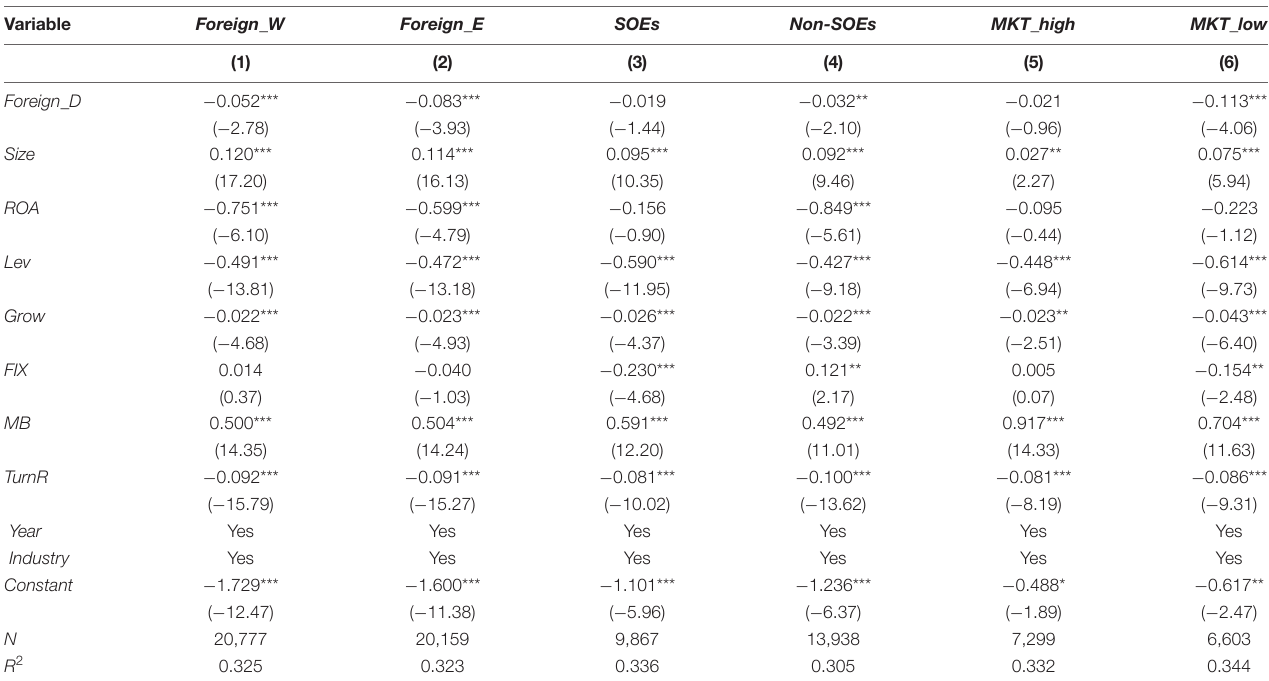
TABLE 11 | Further